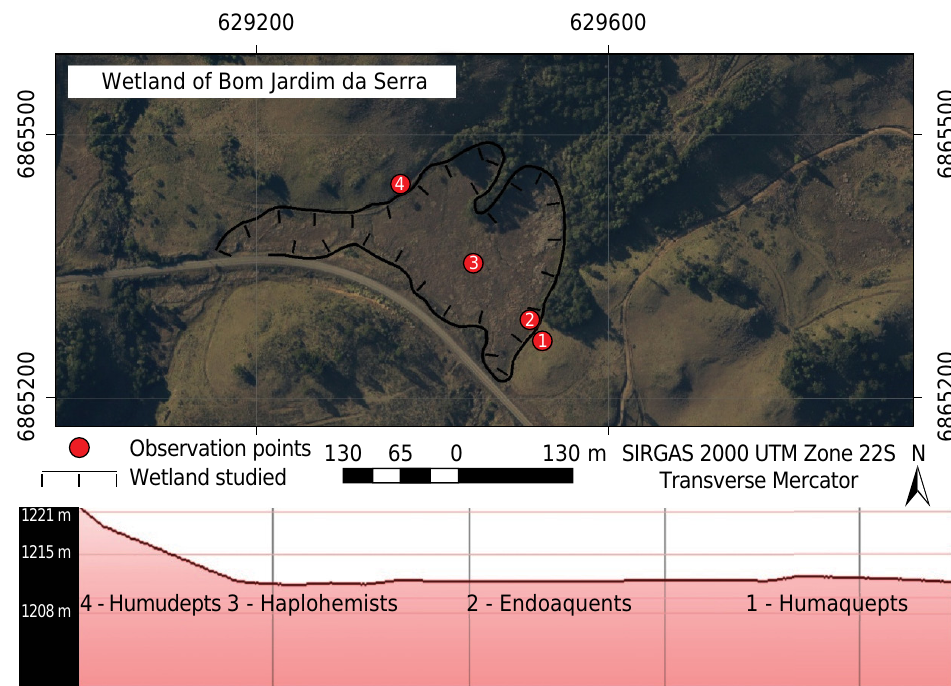
Figure 2. Location of the wetland in the municipality of Bom Jardim da Serra (BJS), SC, and elevation profile. Distance between points 1 and 2: 10 m; 2 and 3: 37 m; 3 and 4: 40 m. Figure of the Aerophotogrammetric Survey of the State of Santa Catarina, Brazil,